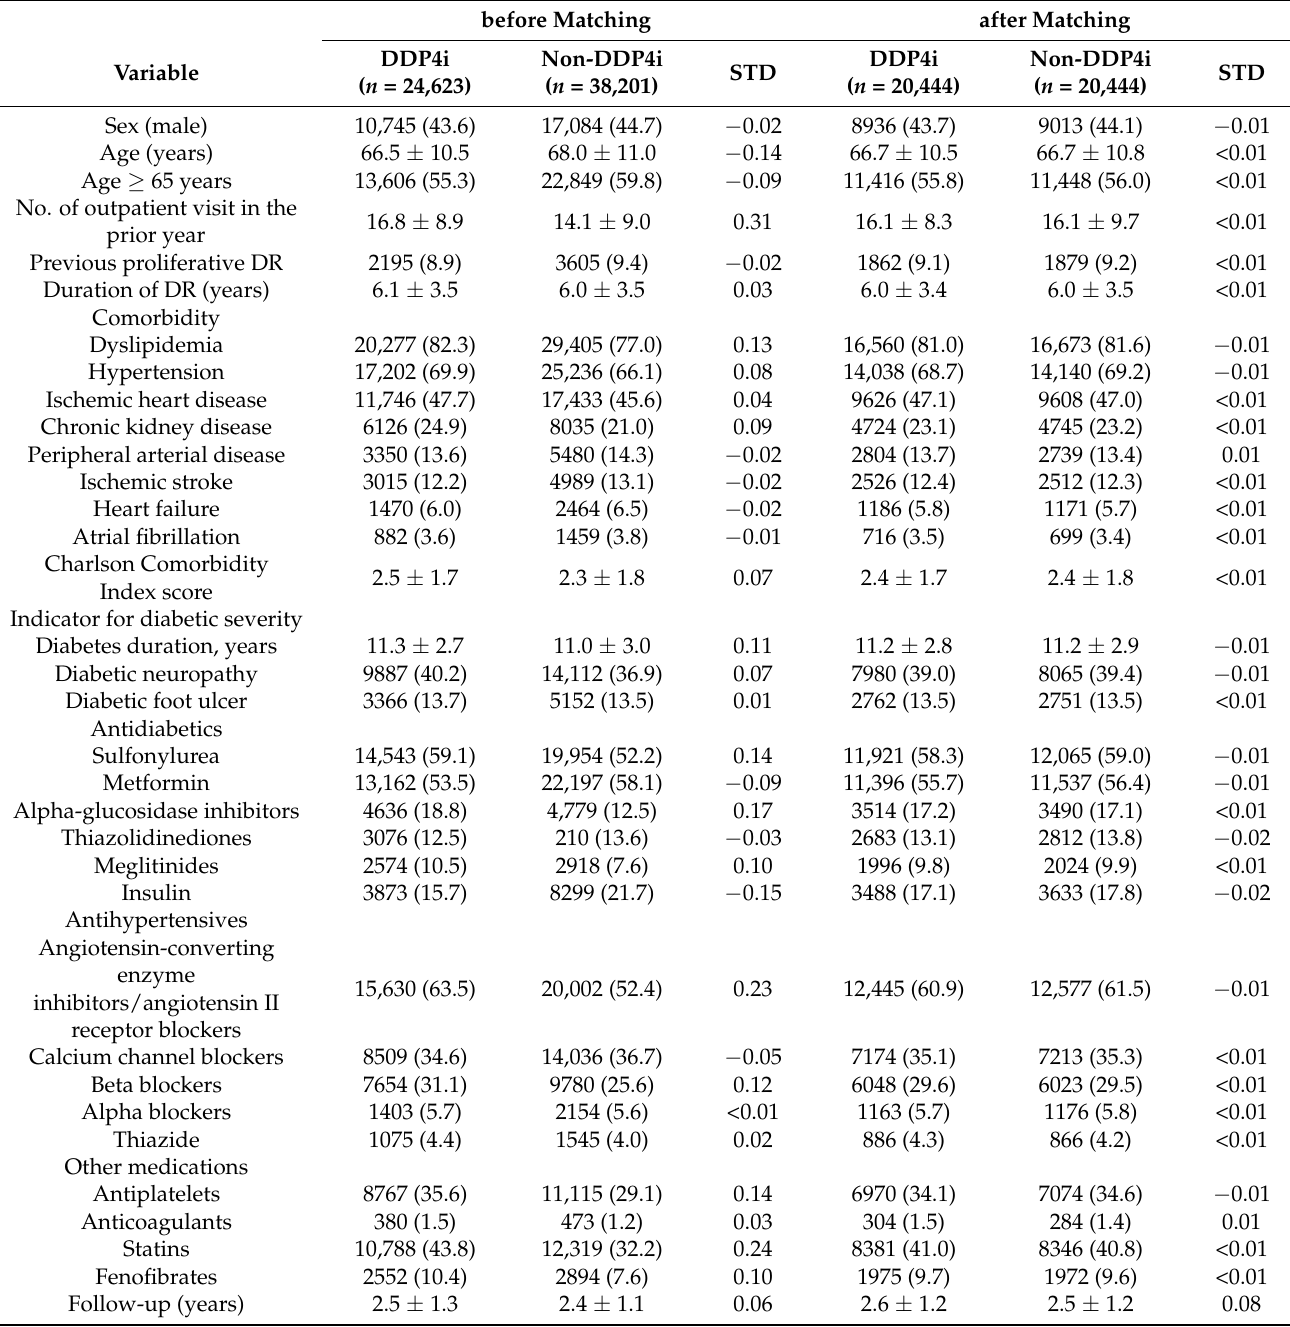
terms of sex, age, comorbidities, indicators for diabetic severity, underlying ocular diseases, medications, and follow-up duration. Table 1. Characteristics of patients with type 2 diabetes and diabetic retinopathy before and after matching. Balance achieved between the DPP4i and non-DPP4i groups after matching. before Matching after